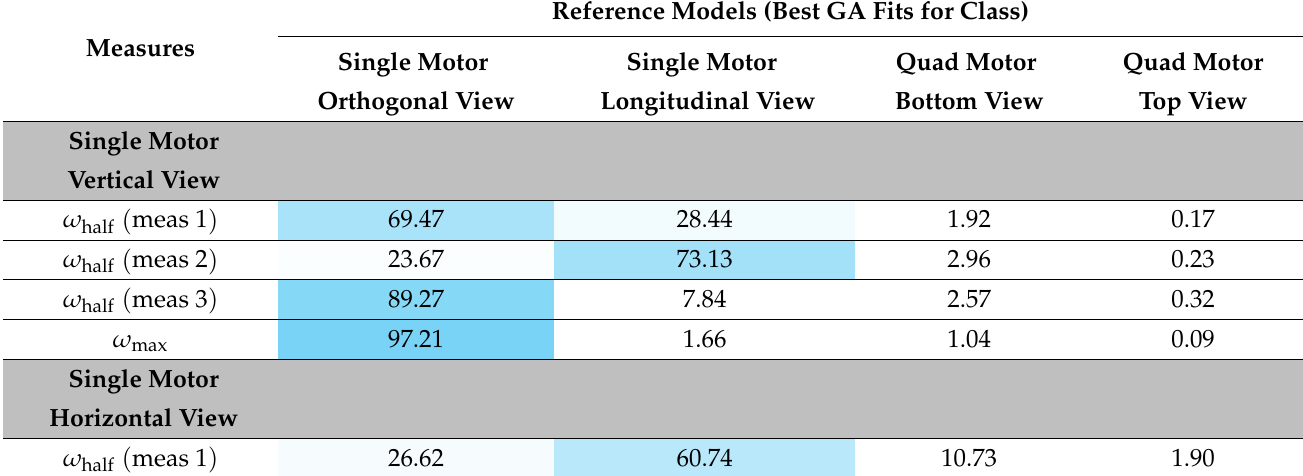
Table 3. Confusion matrix considering different numbers of motors